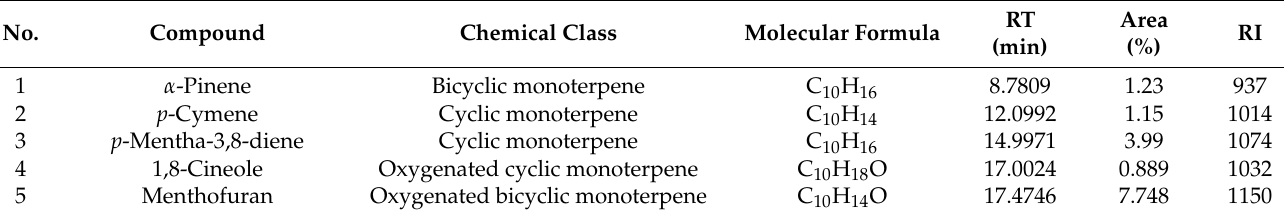
Table 3. Chemical constituents identified from the essential oil of Mentha longifolia